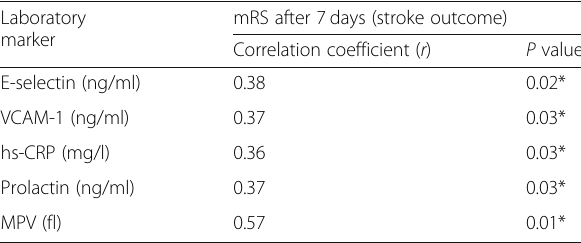
Table 8 Correlation between stroke outcome (measured by mRS) and laboratory markers on